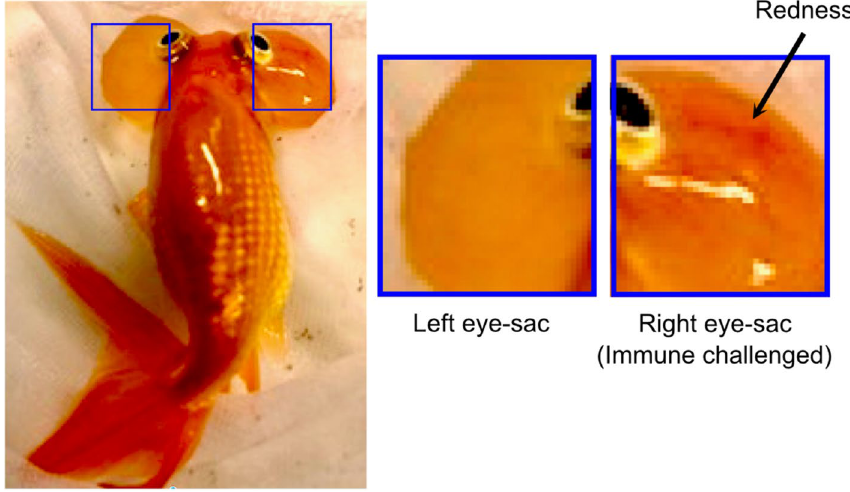
Figure 3. Inflammatory symptom (redness) of the eye sac. Heat-killed P. aeruginosa cells (50 µL of tenfold concentration of full growth) were injected into the right eye sac of the bubble-eye goldfish, while saline (50 µL) was injected into the left eye sac. Redness was observed on the right eye sac as shown in the figure after 20 h.